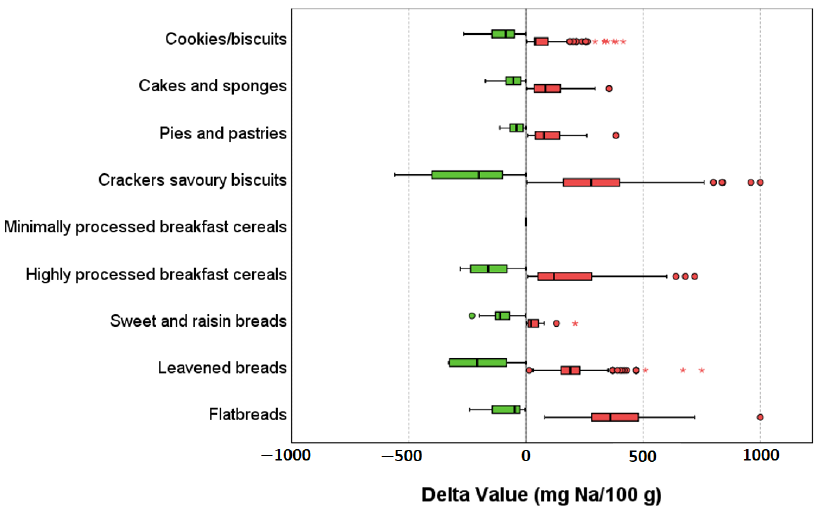
Figure 1. Box-plot representation of the delta sodium (Na) content from the related benchmarks in the different subcategories of cereal-based products. Legend: green and red bars represent the delta values for products with sodium content equal or below and above the benchmark, respectively. Dots and asterisks represent mild and extreme outliers, respectively.